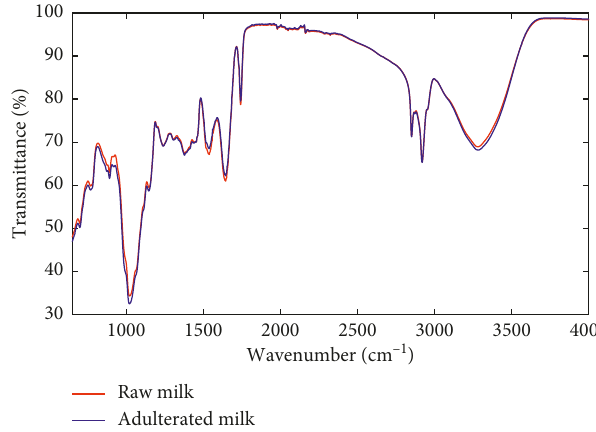
Figure 2: Average FTIR spectral fingerprints of raw and recon- stituted